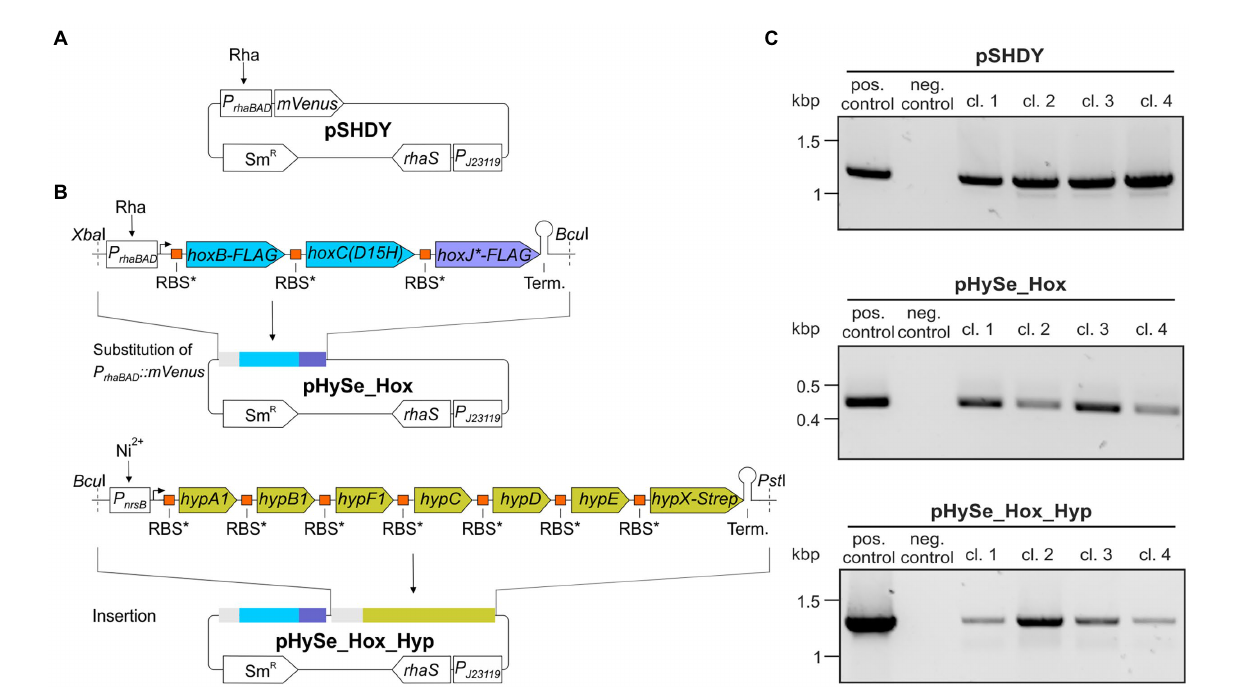
FIGURE 2 Scheme of synthetic operons for the expression of C. necator genes encoding the H 2 -sensing HoxBCJ* complex and its associated maturases in Synechocystis . (A) Structure of the plasmid pSHDY_ P rhaBAD ::mVenus _ P J23119 :: rhaS (herein referred to as pSHDY). It can be maintained in Synechocystis , contains a spectinomycin selection marker (Sm R ) for selection and enables L-rhamnose (Rha)-inducible reporter gene expression via P rhaBAD by featuring a cassette for the constitutive expression of rhaS (Behle et al., 2020). (B) Structure of the pHySe plasmids. The hox and hyp genes are organized in synthetic operons with a transcription terminator (Term.) at the 3 ′ ends. Their polycistronic transcription is driven by P rhaBAD and the nickel-ion (Ni 2+ )- responsive P nrsB (Englund et al., 2016), respectively. Each gene is interconnected by a ribosome binding site, RBS* (Heidorn et al., 2011). (C) Verification of recombinant Synechocystis strains. A Synechocystis parental strain lacking the endogenous hydrogenase was transformed using either pSHDY, pHySe_Hox, or pHySe_Hox_Hyp. Four selected clones (cl.1–4) were analyzed by colony PCR with primers that specifically targeted regions of the particular vector, i.e., S17 and S31 for pSHDY, S22 and S31 for pHySe_Hox, as well as S30 and S31 for pHySe_Hox_Hyp. The respective pure plasmid DNA served as positive control (pos. control). A PCR reaction lacking a template was used as negative control (neg.